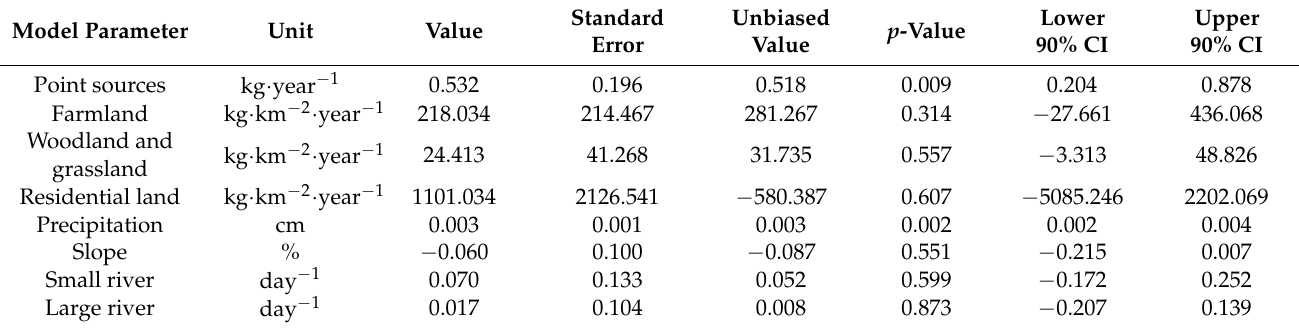
Table 3. Evaluation of parameters in PLB.